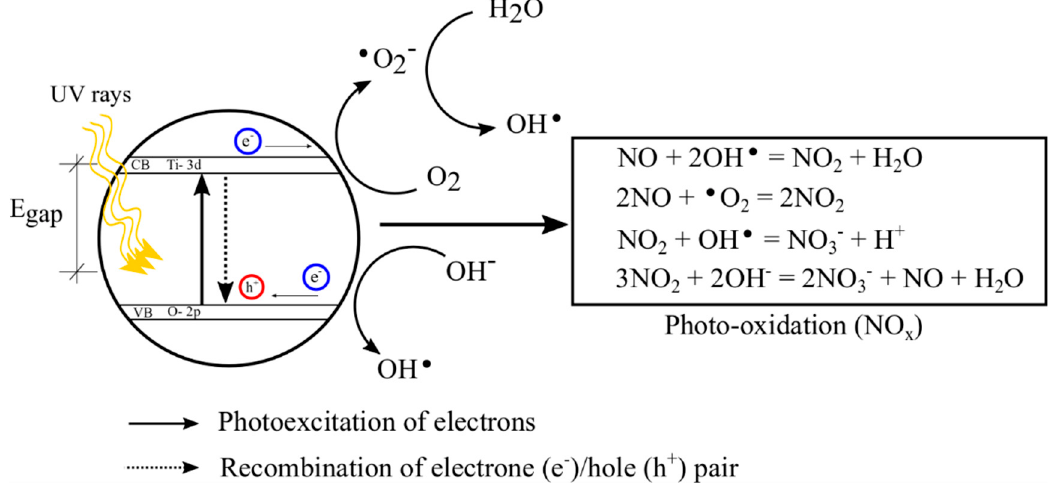
Figure 1. Nitrogen oxide (NO x ) removal mechanism using titania (TiO 2 ).